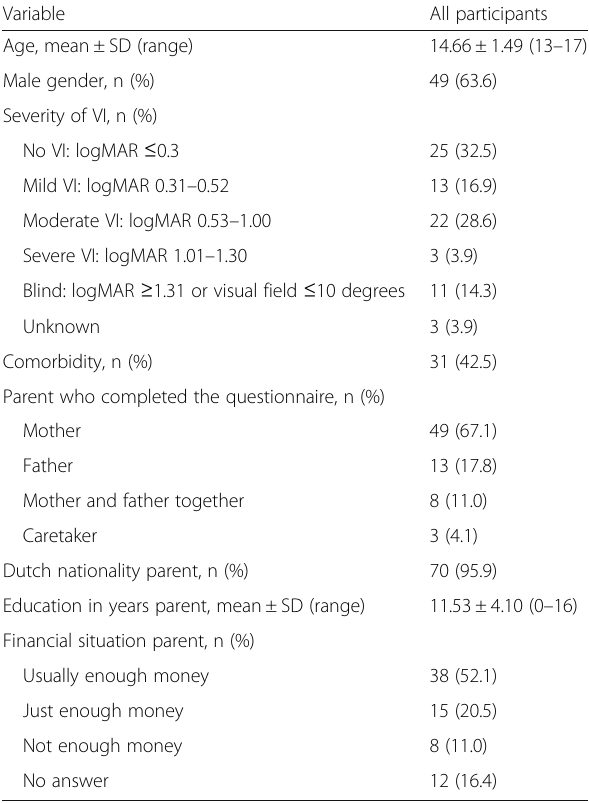
Table 1 Socio-demographic and clinical characteristics of